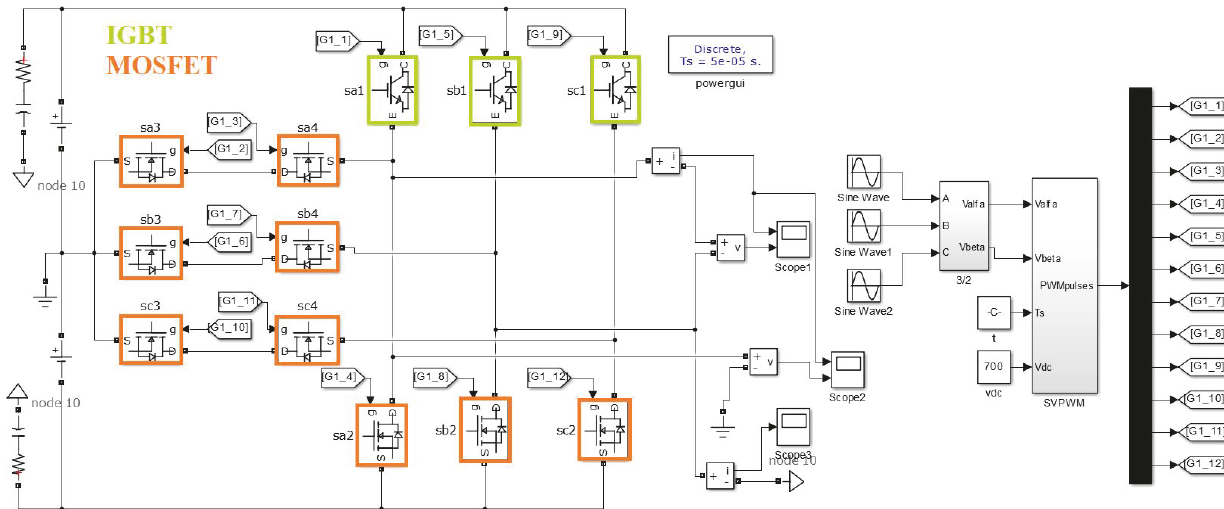
Figure 12: The simulation model of the SVPWM controlled novel T-type three-phase three-level